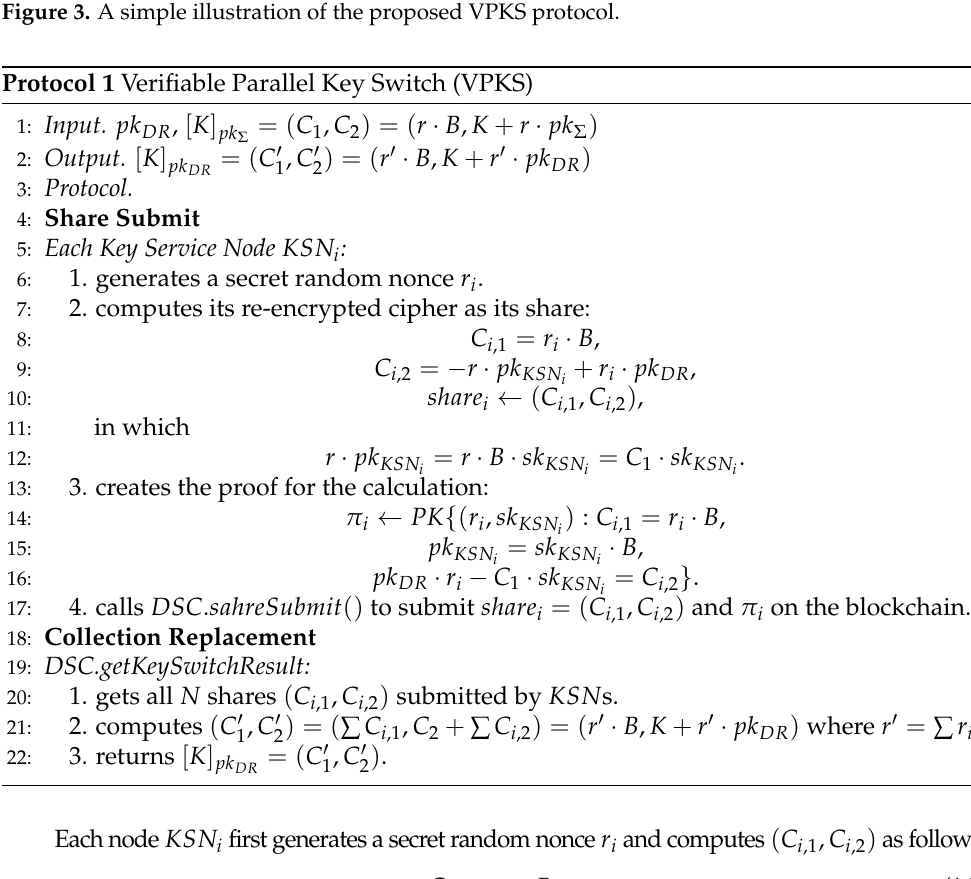
Figure 3. A simple illustration of the proposed VPKS